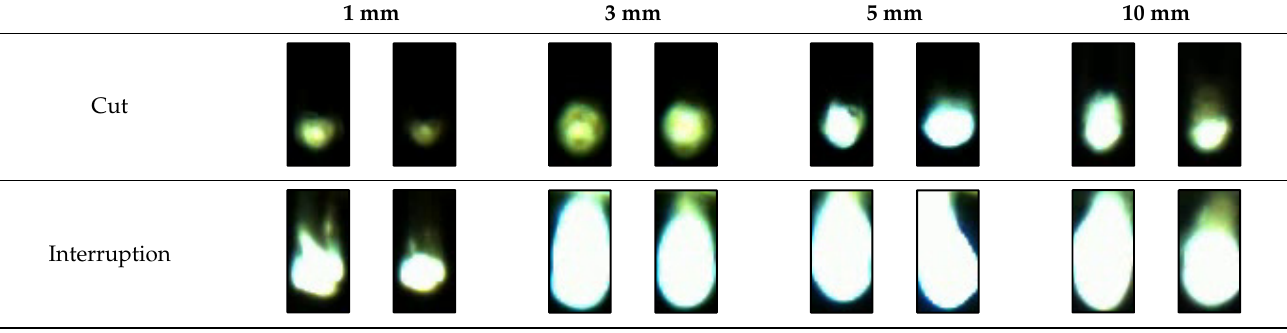
Table 2. Cut images for different sheet thicknesses and cut states.